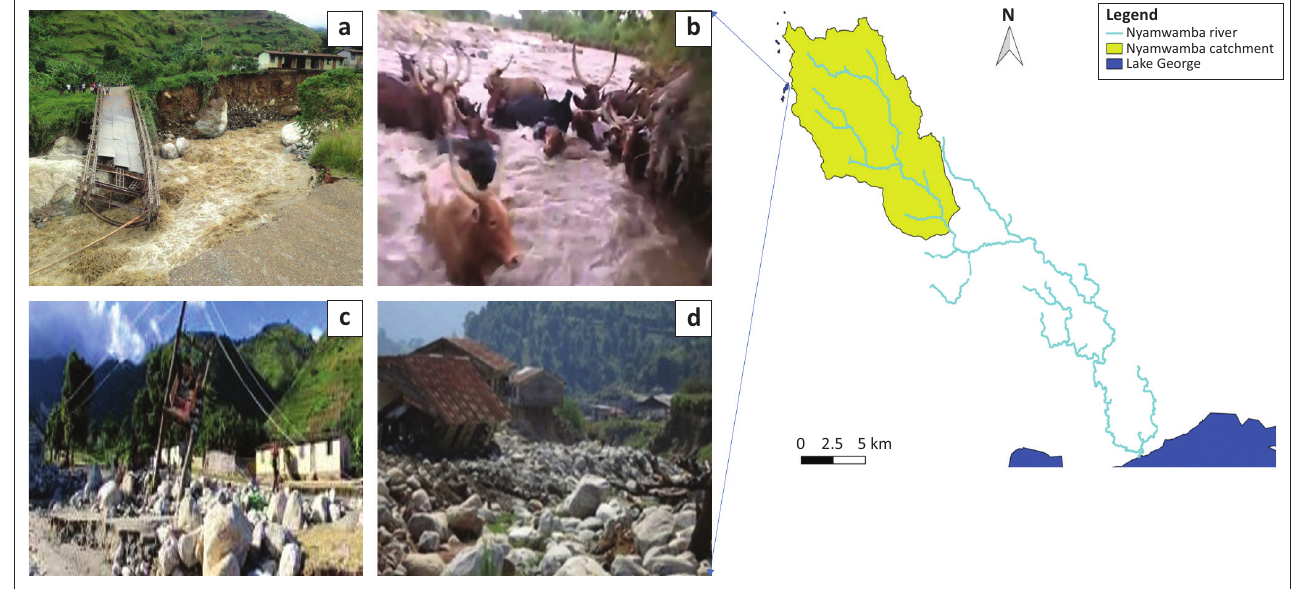
FIGURE 2: Sample damages caused by floods in the Nyamwamba watershed; pictures are from the Nyamwamba catchment on the Nyamwamba watershed. (a) Destruction of bridges, (b) cows trapped in flood, (c) destruction of live lines and (d) destruction of residential